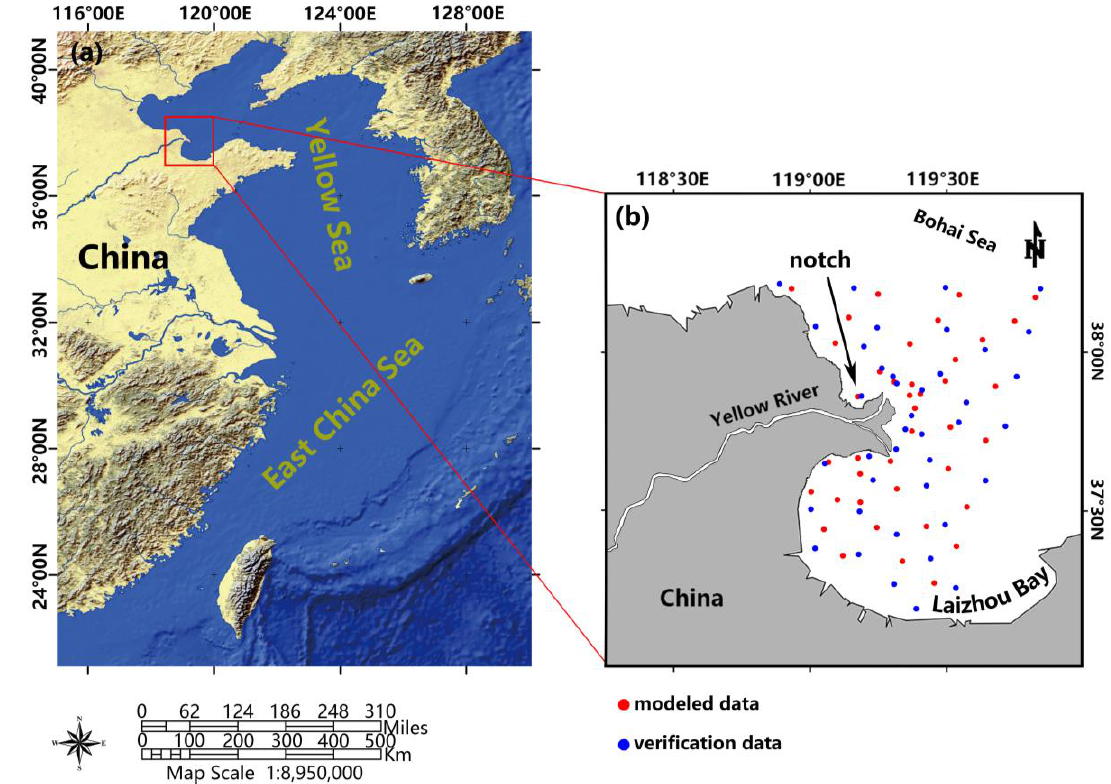
Figure 1. ( a ): Location of the Yellow River Estuary; ( b ): Position of 80 suspended sediments concentrations (SSC) in-situ measurements used in study area; red points present 40 SSC in-situ measurements for establishing the model and the blue points present 40 SSC in-situ measurements for verification.